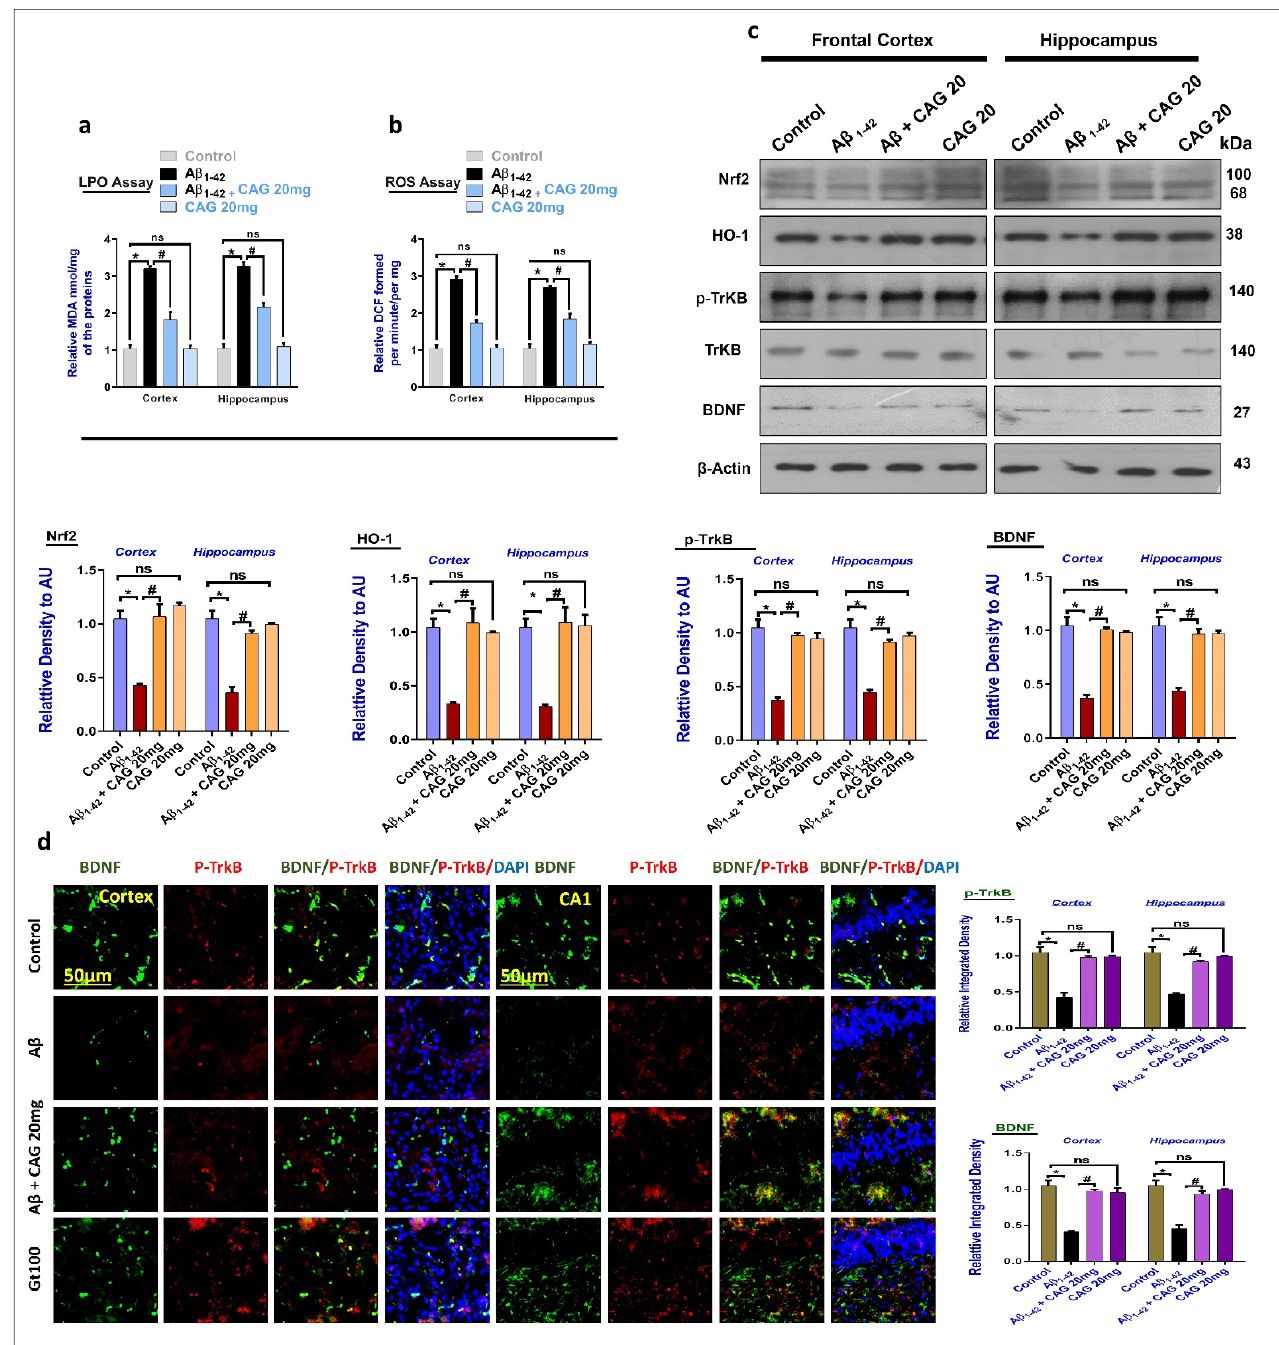
Figure 1. Effects of cycloastragenol against the elevated oxidative stress and altered expression of BDNF and p-TrkB in the A β -injected mice. ( a , b ) Graphical representation of LPO and ROS assays in vivo. ( c ) Western blot results of Nrf2, HO-1, p-TrkB, TrkB, and BDNF in the frontal cortex and hippocampus of the experimental mice, with respective bar graphs. ( d ) Immunofluorescence of BDNF and TrkB in the frontal cortex and hippocampus (CA1) of the experimental mice brain. The scale bar is 50 μ m, green is BDNF, red is p-TrkB, and blue is DAPI for nuclear staining. The p -value <0.05 was considered a significant difference. * showing a significantly different from the control group; # significantly different from the A β -injected group. Significant difference = * p < 0.05; # p < 0.05. CAG20: Cycloastragenol 20 mg/kg, DAPI: 4 ′ ,6-diamidino-2-phenylindole, A β : Amyloid beta, CAG: Cycloastragenol, ns: non-significant difference.